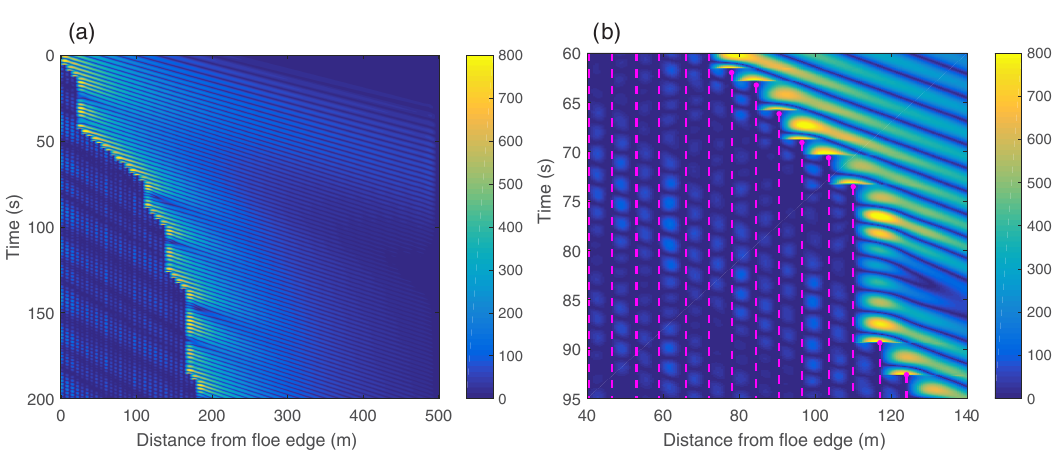
Figure 10. As in Fig. 8 but for irregular incoming waves with Jonswap energy spectrum (wave height and peak period corresponding to those of sine waves used in simulation from Fig.